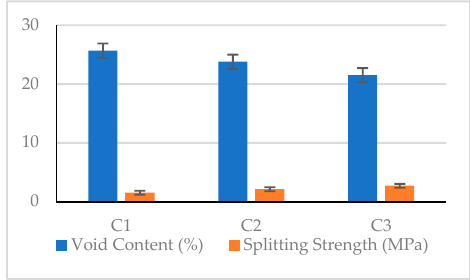
Figure 13. S / N response graph showing the flexural strength of pervious concretes.